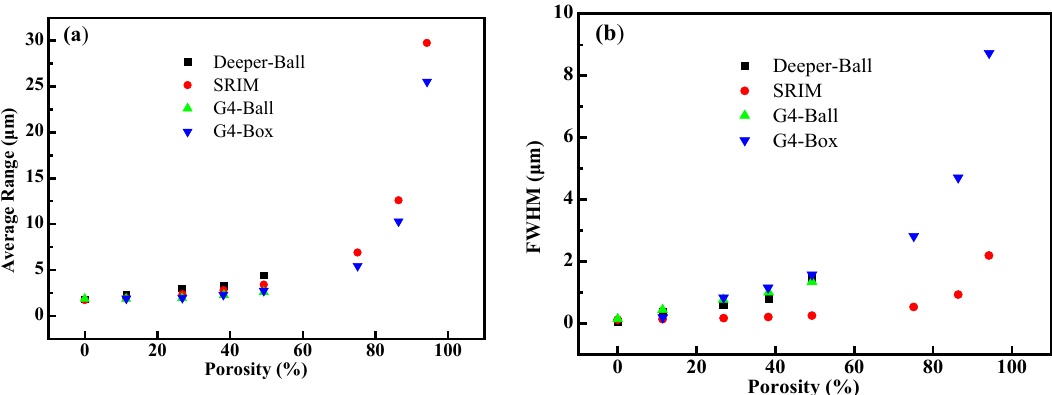
Figure 6. The transport results calculated by different software (G4-Ball represents the GEANT4 simulation results with spherical voids, while the G4-Box represents the GEANT4 simulation results with cubic ones, and Deeper-ball represents the Deeper simulation results with spherical voids): ( a ) the relationship between average range and porosity; ( b ) the relationship between FWHM and porosity.